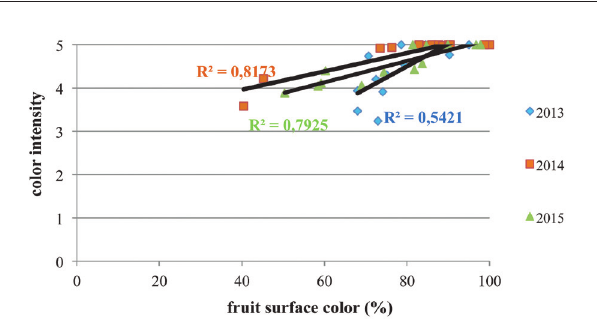
Figure 3 : Relationship between fruits surface colour and colour intensity of apple cultivars (Nyírbátor,